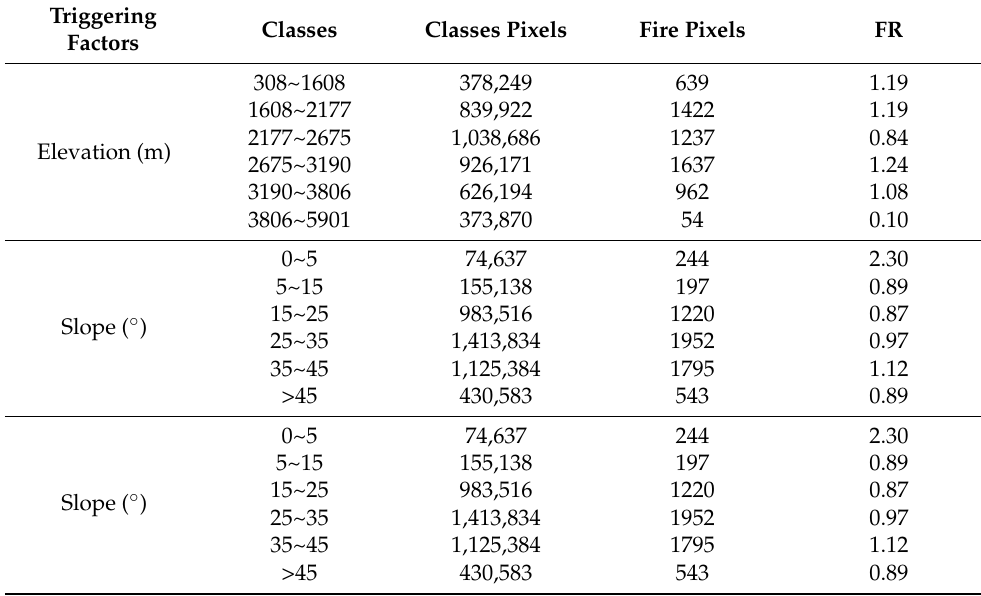
Figure A1. Grading diagram of each fire triggering factor; ( a ) Elevation, ( b ) Slope, ( c ) Aspect, ( d ) TWI, ( e ) Average temperature, ( f ) Maximum temperature, ( g ) Precipitation, ( h ) Land cover, ( i ) NDVI, ( j ) Population density. Table A2. Frequency ratios of different triggering factor categories.